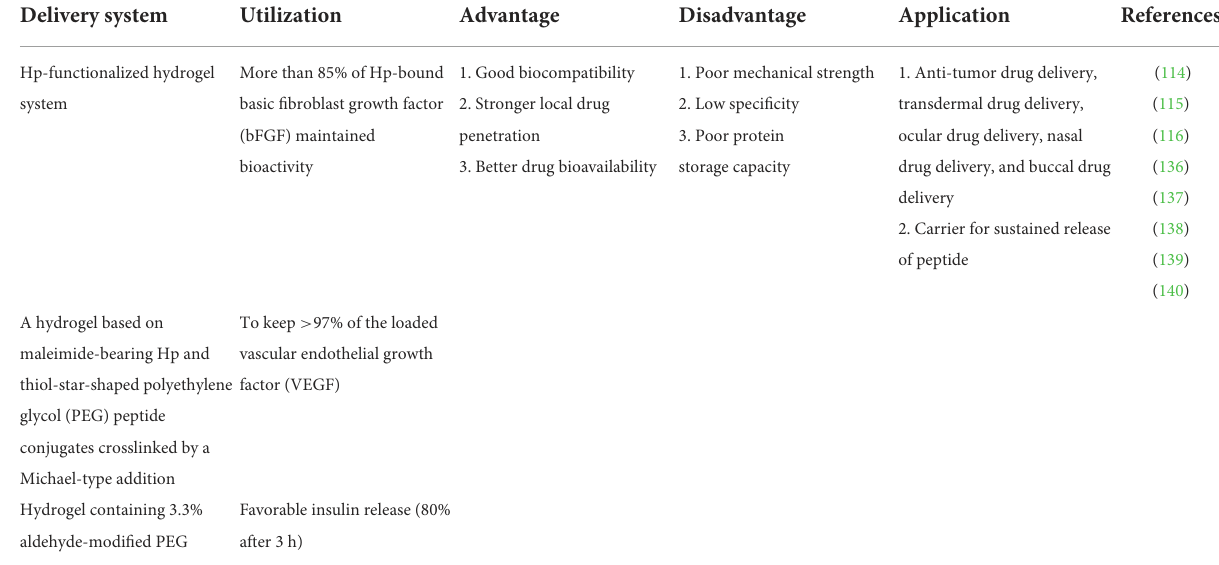
TABLE 6 Application and characterization of